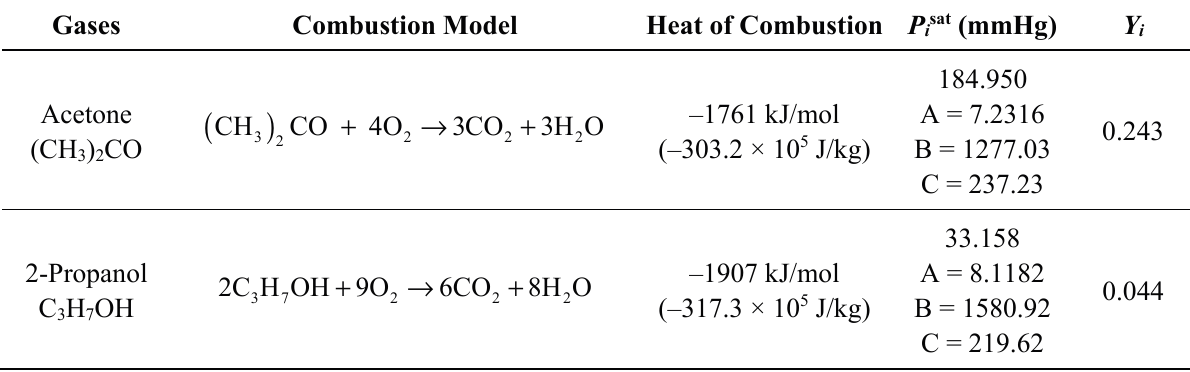
Table 1. Global one-step reaction models, saturation pressure, and mole fraction in air of acetone and